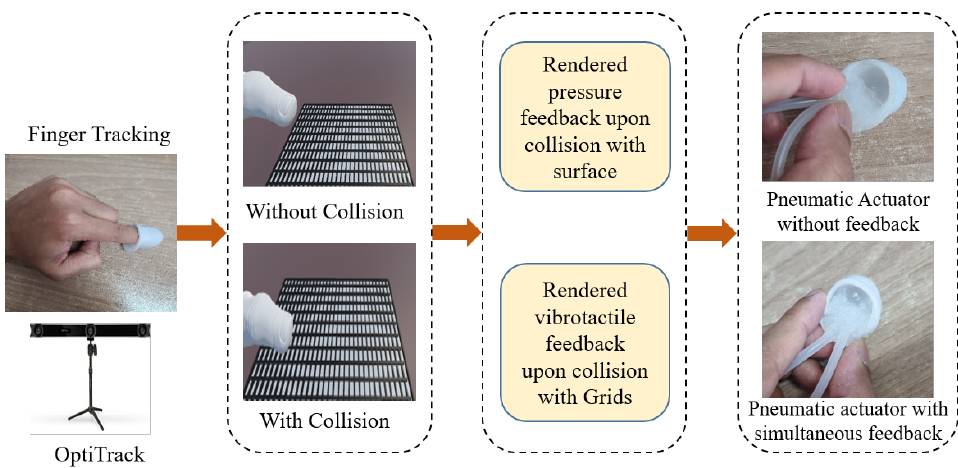
Figure 4. Proposed framework for haptic texture